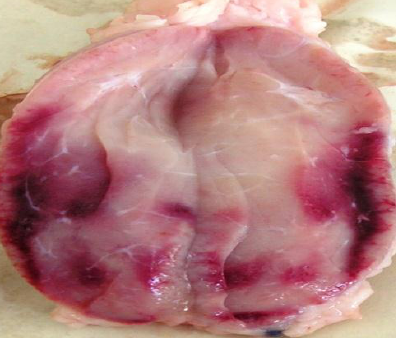
Figure 5: Microscopic view of the lymph node illustrated in figure 3 showing reactive follicular hyperplasia in the cortex, enlargement of germinal centers and slight increase of the inter-follicular lymphoid tissue. H and E stain, X100.